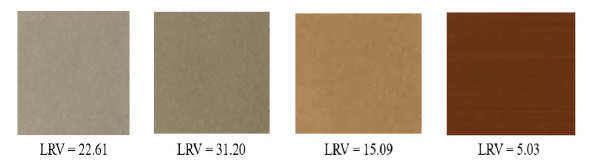
Figure 4. Light Reflectance Values for different surface rust colors.